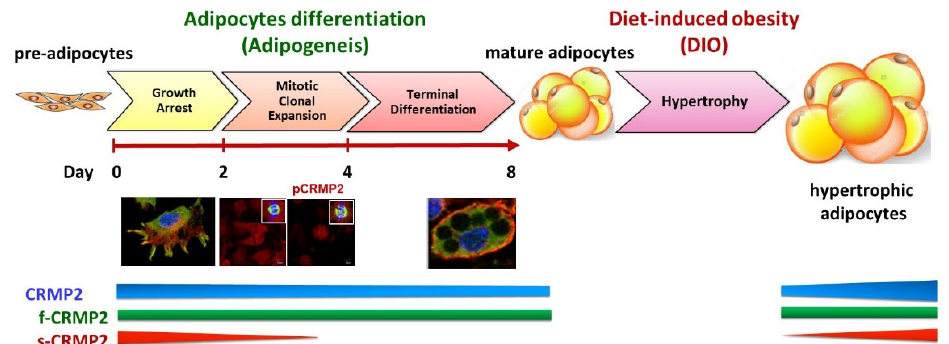
Figure 7. Implication of CRMP2 expression profile in physiological and pathological metabolic circumstances (scale bar = 10 μ m).